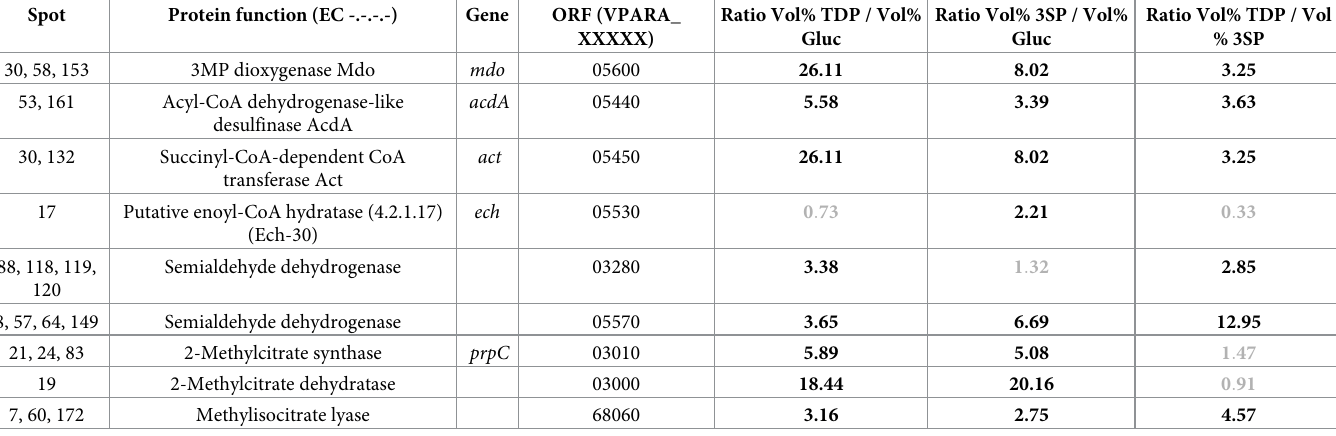
Table 3. Proteins from our postulated and partly verified TDP metabolism detected via proteome analysis. The table includes the spot numbers in the 2D gels (S1–S3 Figs), the protein function and the corresponding locus tag. The highest relevant ratios of mean normalized spot volumes are indicated in black; insignificant ratios are dis- played in